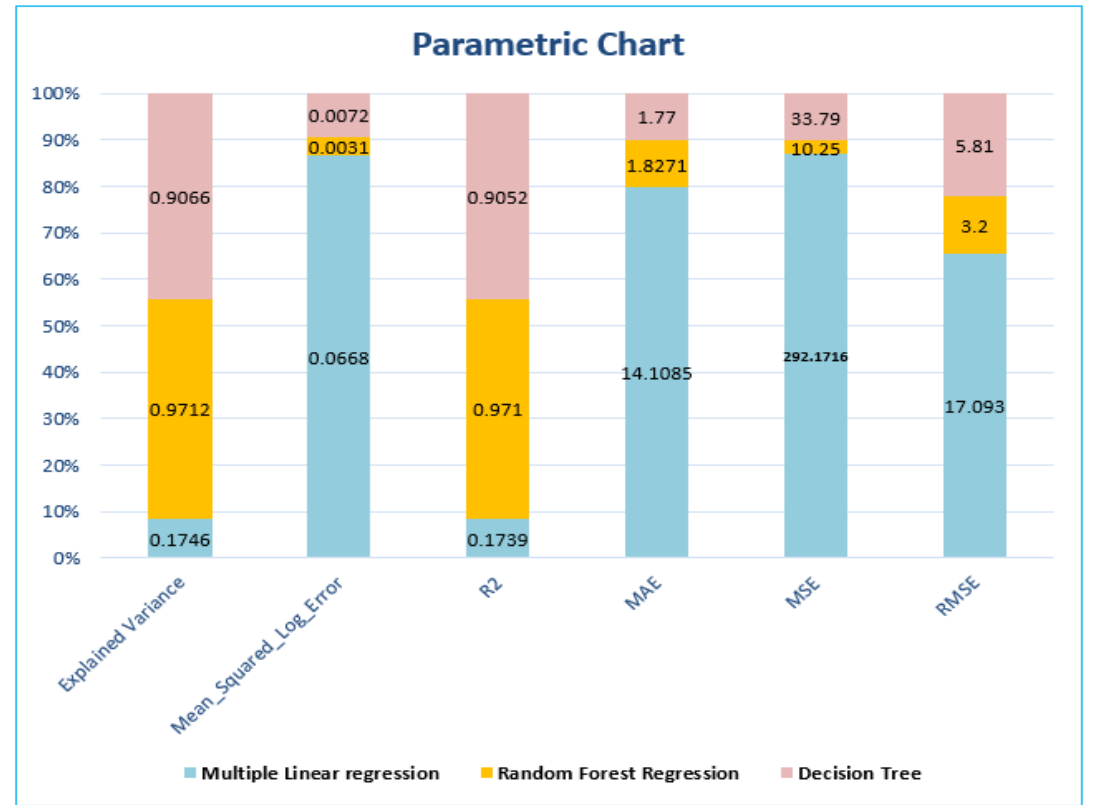
Figure 16. Parametric Analysis.